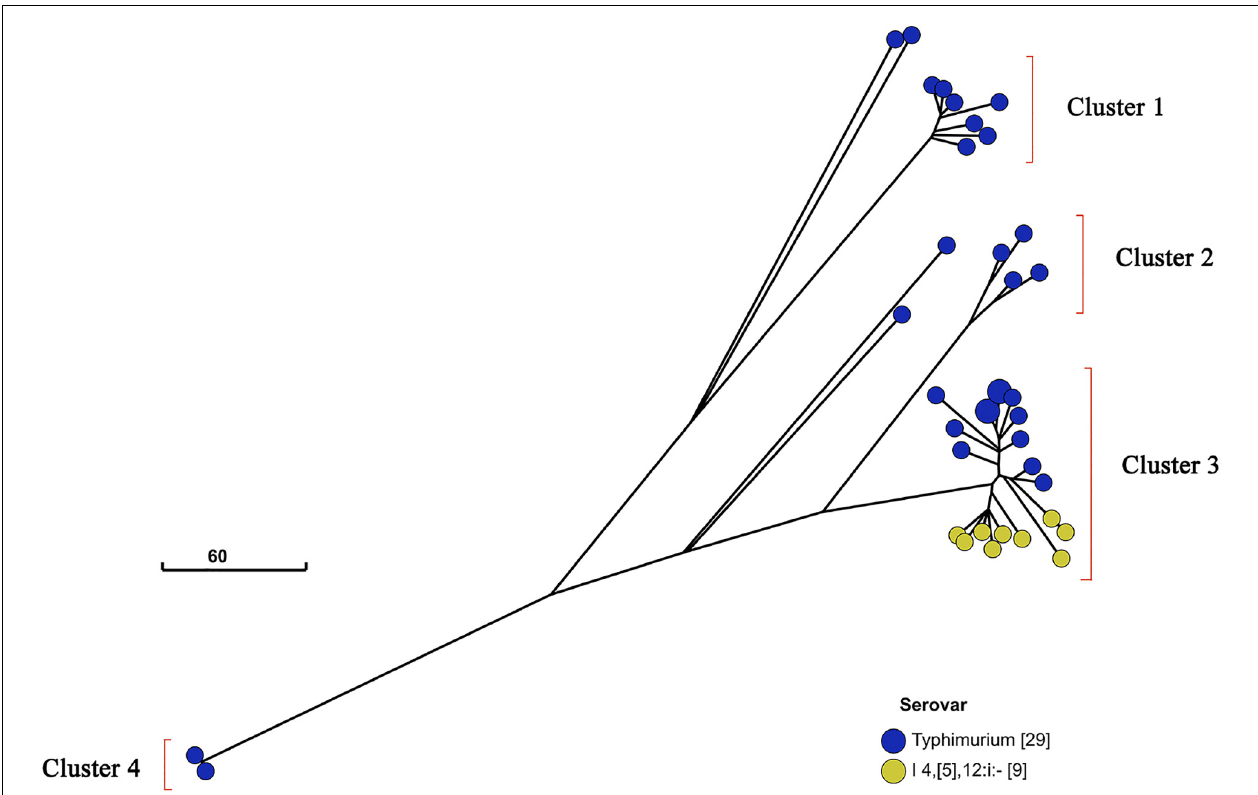
FIGURE 5 | GrapeTree of Salmonella serovar I 4,[5],12:i:- and Typhimurium isolates. GrapeTree of nine serovar I 4,[5],12:i:- isolates and 29 serovar Typhimurium isolates constructed based on cgMLST information by EnteroBase GrapeTree function and neighbor-joining algorithm. These 38 isolates belong to four clusters in the tree, and all nine serovar I 4,[5],12:i:- isolates belong to cluster 3 with 12 serovar Typhimurium isolates, showing that Salmonella serovar I 4,[5],12:i:- and Typhimurium have a closer genetic